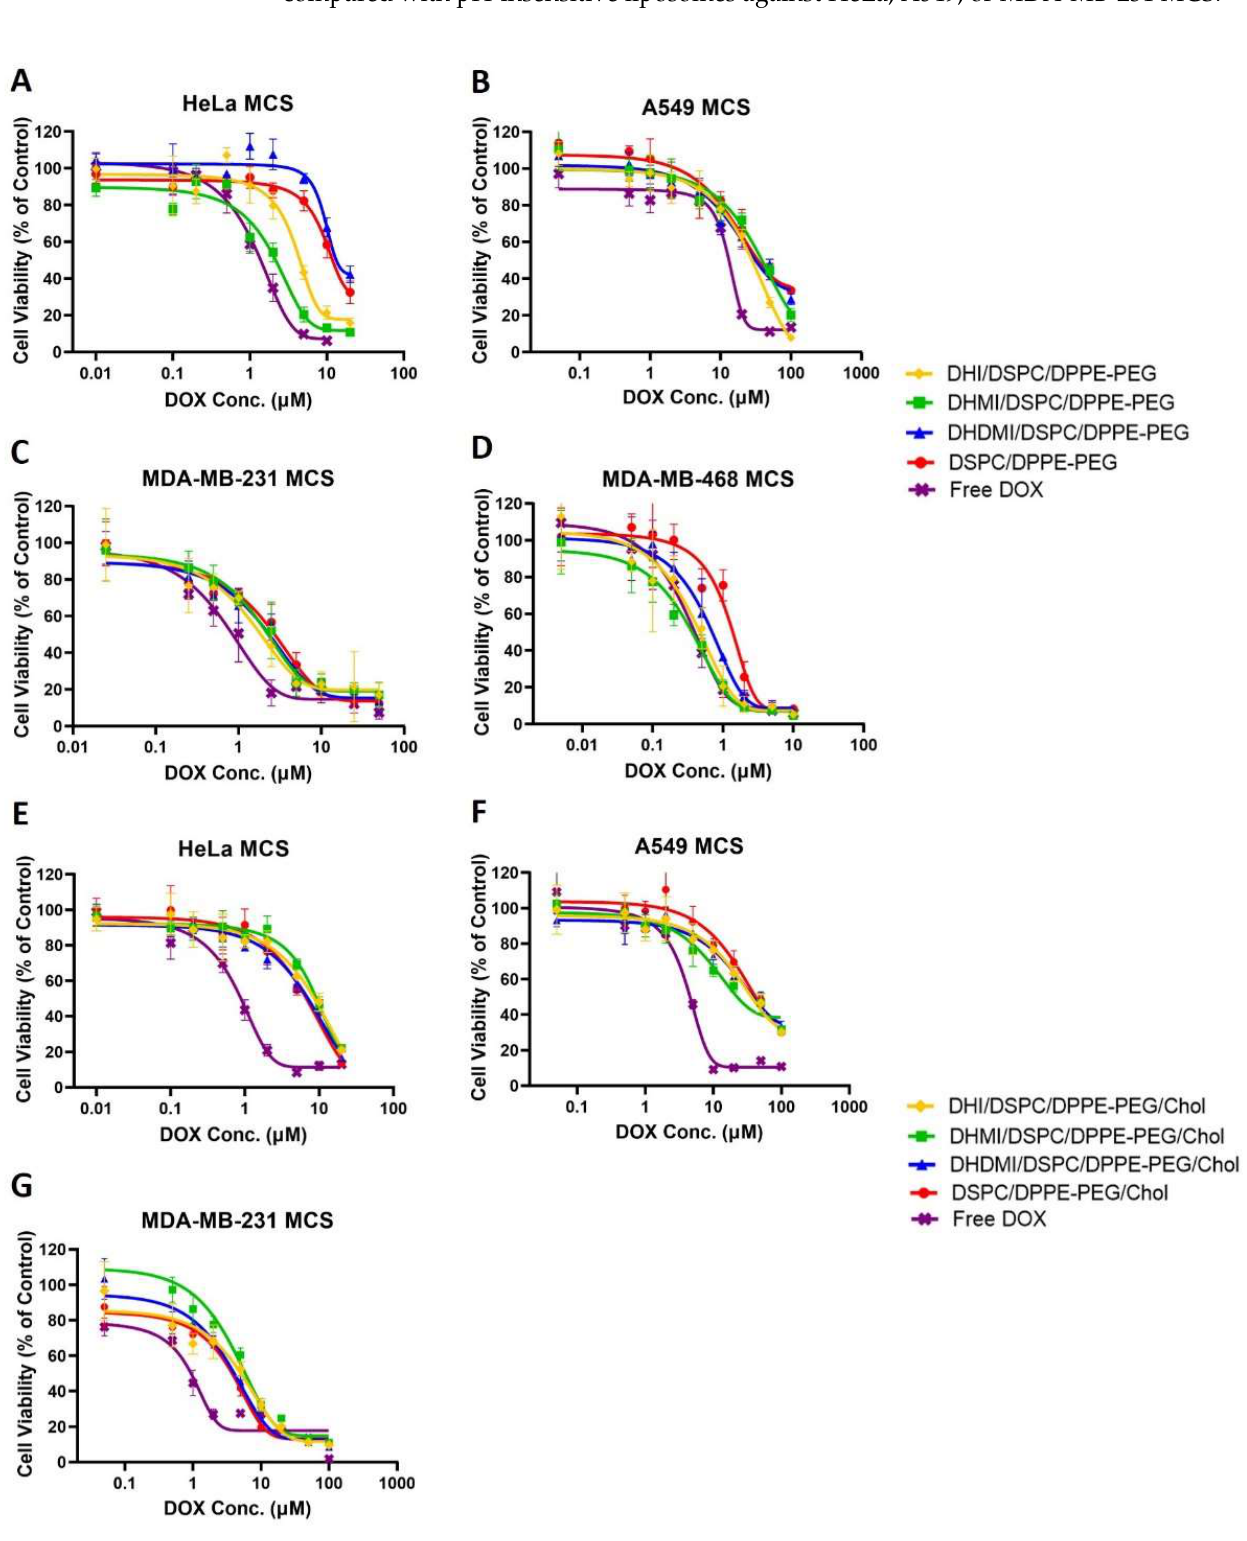
Figure 10. Cell viability of Hela, A549, MDA-MB-231, and MDA-MB-468 MCS after treatment with incremental concentrations of ICL formulations, pH-insensitive liposome, or free DOX. ICL consisted of either no cholesterol ( A – D ) or 25 mol% cholesterol ( E – G ). Data are presented as mean ± SD, N = 4.